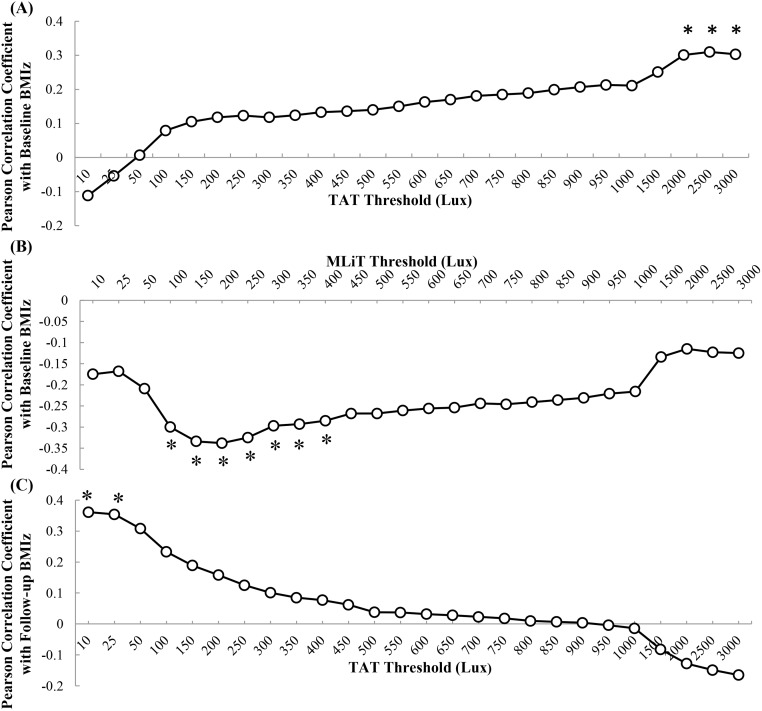
Sensitivity Analyses showing Pearson correlations between BMI z score and a range of MLiT and TAT Light Thresholds (lux) at baseline and follow-up.* indicates statistically significant at p < .05. (A) TAT thresholds of 2000–3000 lux were significantly associated with BMI z score at baseline, with TAT2500 having the strongest association (N = 48). (B) MLiT thresholds of 100–400 lux were significantly associated with BMI z score at baseline, with the strongest association at MLiT200 (N = 48). (C) TAT thresholds of 10–25 lux were significantly associated with follow-up BMI z score, with the strongest association at TAT10 (N = 39).